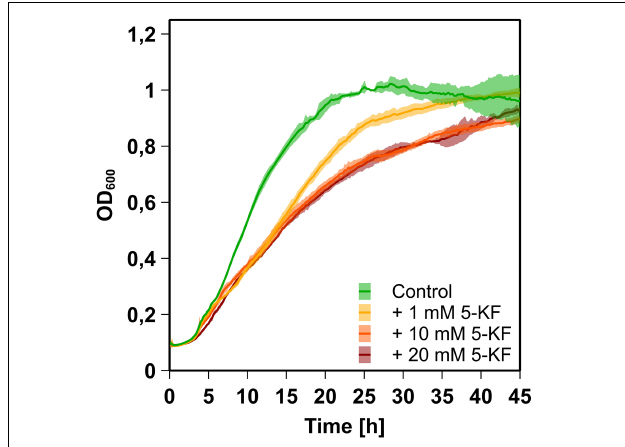
FIGURE 2 | Growth behavior of B. subtilis DSM 10 cultures supplemented with and without 5-KF. B. subtilis DSM 10 was grown in Spore minimal medium (Demain, 1958) at 30 ◦ C without 5-KF (green), or with 1 mM (yellow), 10 mM (orange), or 20 mM (red) 5-KF. OD 600 was measured every 5 min by a Tecan Infinite M200 plate reader (Tecan Group AG). The dark, central line of the growth curves reflects the mean of each biological triplicate, while the lighter area above and below displays the standard deviation. After 28.5 h of incubation, when the control culture reached a maximum OD 600 , all cultures treated with 5-KF displayed significantly lower optical densities ( p < 0.0001). Dunnett’s multiple comparisons test was performed using GraphPad 9.3.1 (GraphPad Software, San Diego, US) to determine statistical